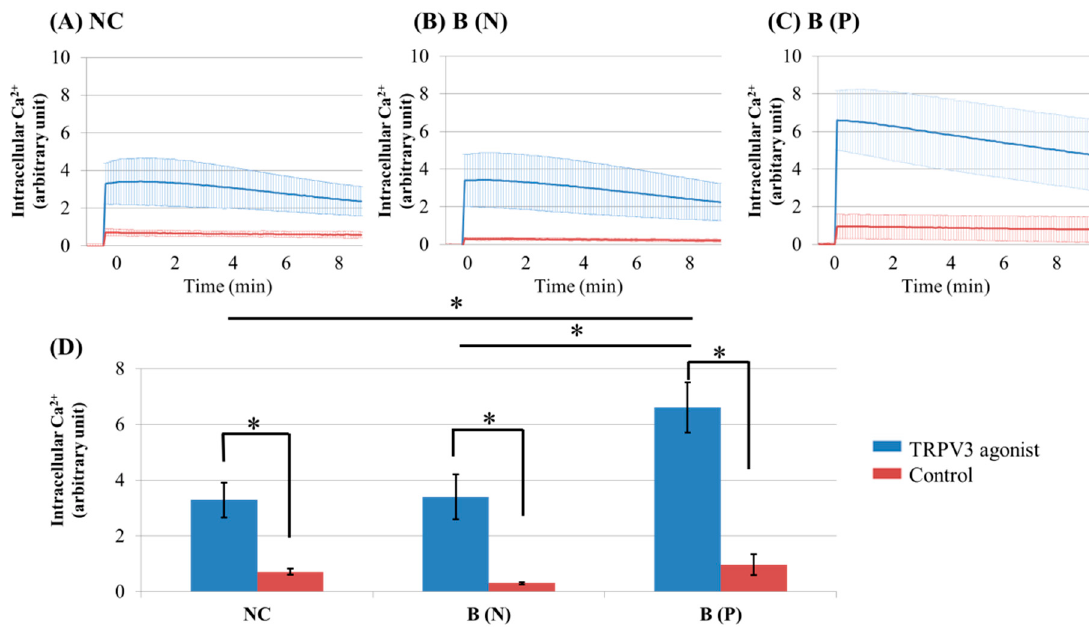
Figure 1. Ca 2+ influx in cultured keratinocytes of: ( A ) Normal control; ( B ) Nonpruritic burn scar and ( C ) pruritic burn scar; ( D ) Intracellular Ca 2+ levels at the time of TRPV3 agonist treatment. Each group was treated with TRPV3 agonist (500 μ M Carvacrol and 200 μ M 2-APB mixture) and Ca 2+ buffer with 0.5 M ethylenediaminetetraacetic acid (EDTA) was used for control. The Ca 2+ influx in cultured keratinocytes decreased slowly with time. NC: keratinocytes from normal control; B (N): keratinocytes from a nonpruritic burn scar; B (P): keratinocytes from a pruritic burn scar; Error bars in ( A – C ): standard deviation of the mean value obtained from three experiments; Error bars in ( D ): standard error, each performed in triplicate.* p < 0.001.